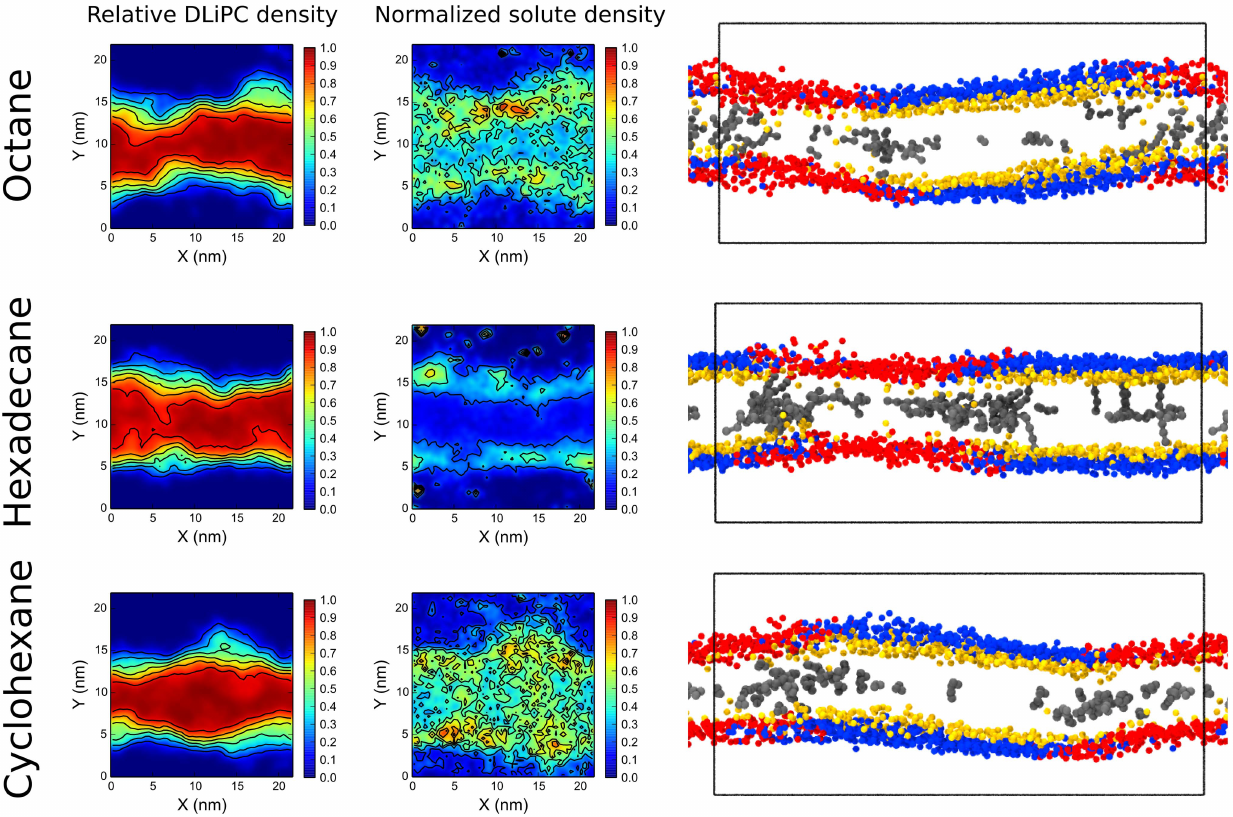
Figure 3. Aliphatic compounds act as linactants. Localization of DLiPC lipids and aliphatic solutes (averaged over the last 100 ns of simulation at low solute concentration, 295 K) expressed as relative density d DLiPC = d DLiPC z d DPPC ð Þ½ (cid:2) and normalized solute density d solute = d MAX panels: snapshots from the same simulations, side view. Only one particle per lipid is shown; phosphate group is colored in red for DLiPC and in blue for DPPC, cholesterol hydroxyl group is in yellow, solutes in gray.